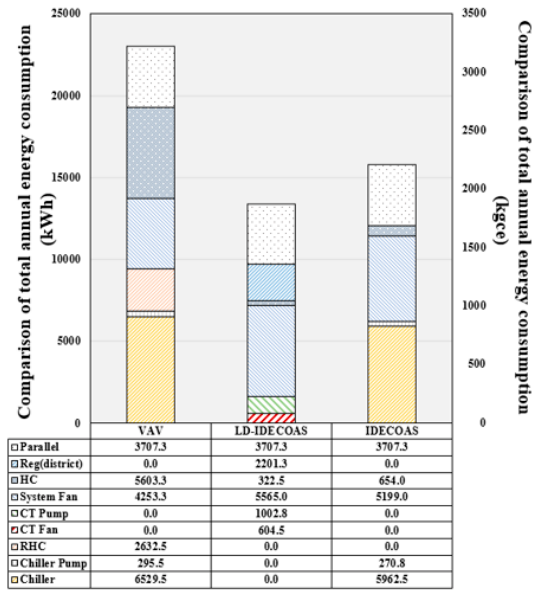
Figure 21. The total annual energy consumption of each system in the Xi’an region.